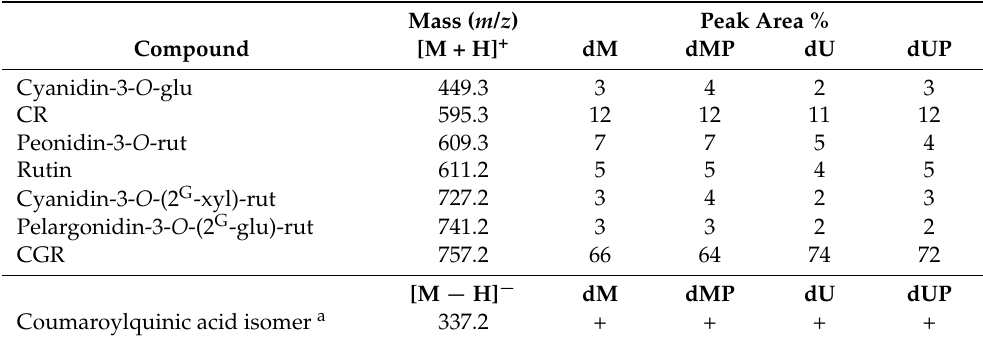
Table 3. Anthocyanins and polyphenolic compounds identified by DI-ESI-MS analysis of four selected